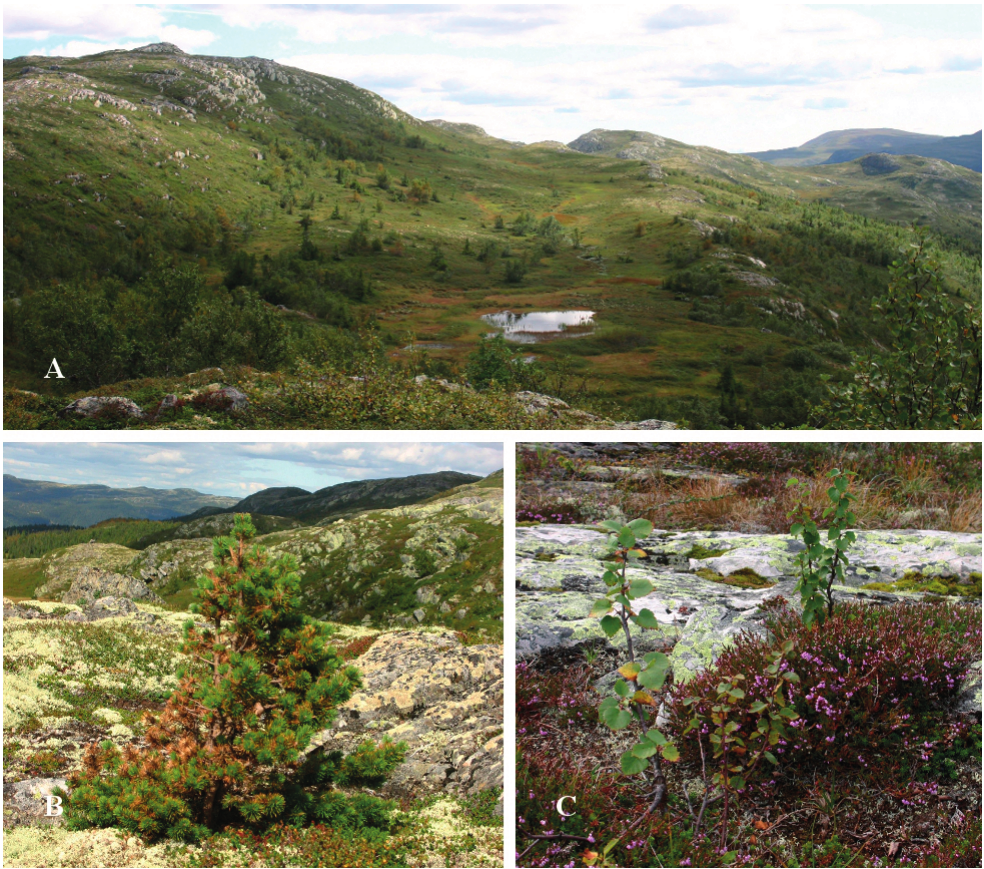
Figure 2. ( A ) Example for typical conditions at a field site along the transect. ( B ) and ( C ) Example for typical sample